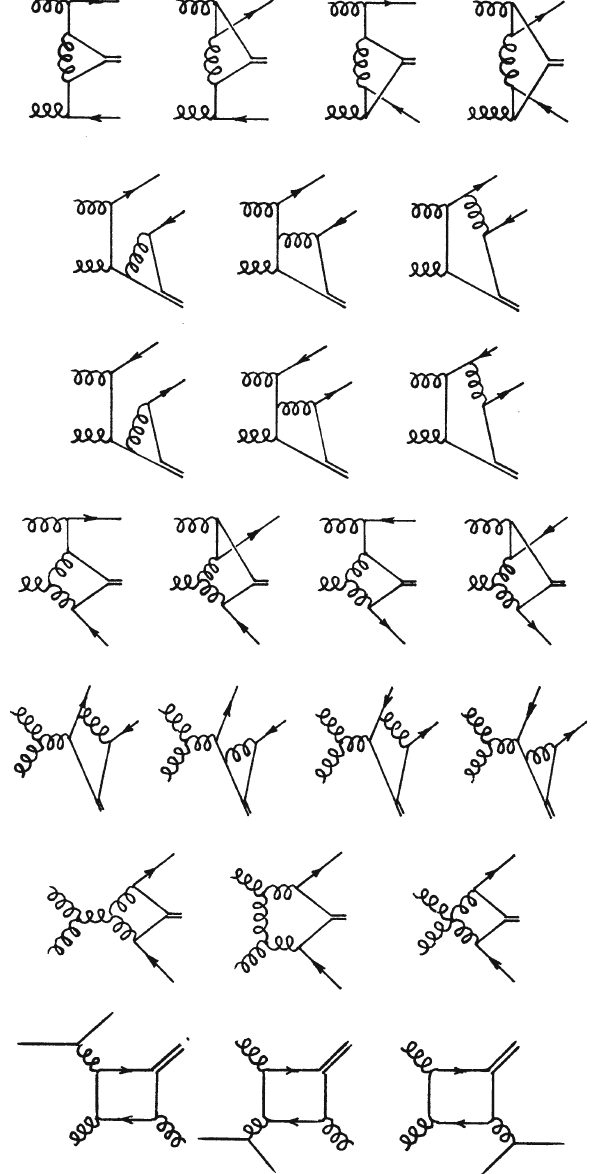
Fig. 3 Feynmandiagramsrepresentingthegluon-gluonfusionprocess gg → J /ψ + c +¯ c atfullleadingorder.Onlyafewofthelisteddiagrams can be interpreted as a c -quark fragmentation ∼ 1 / m c , should be projected to the large-size charmonium wave function. Neglecting the small size of the dipole, one arrives at a simple result, the value of the radial wave function at the origin | R ( 0 ) | 2 . While the charmonium wave function with realistic potentials is known, and its convolution with the dipole size distribution would be more accurate [17,18], we rely here on the small-dipole approximation. Then, the ψ production probability contains only one parameter, | R ( 0 ) | 2 , which is known from the charmonium leptonic decay width